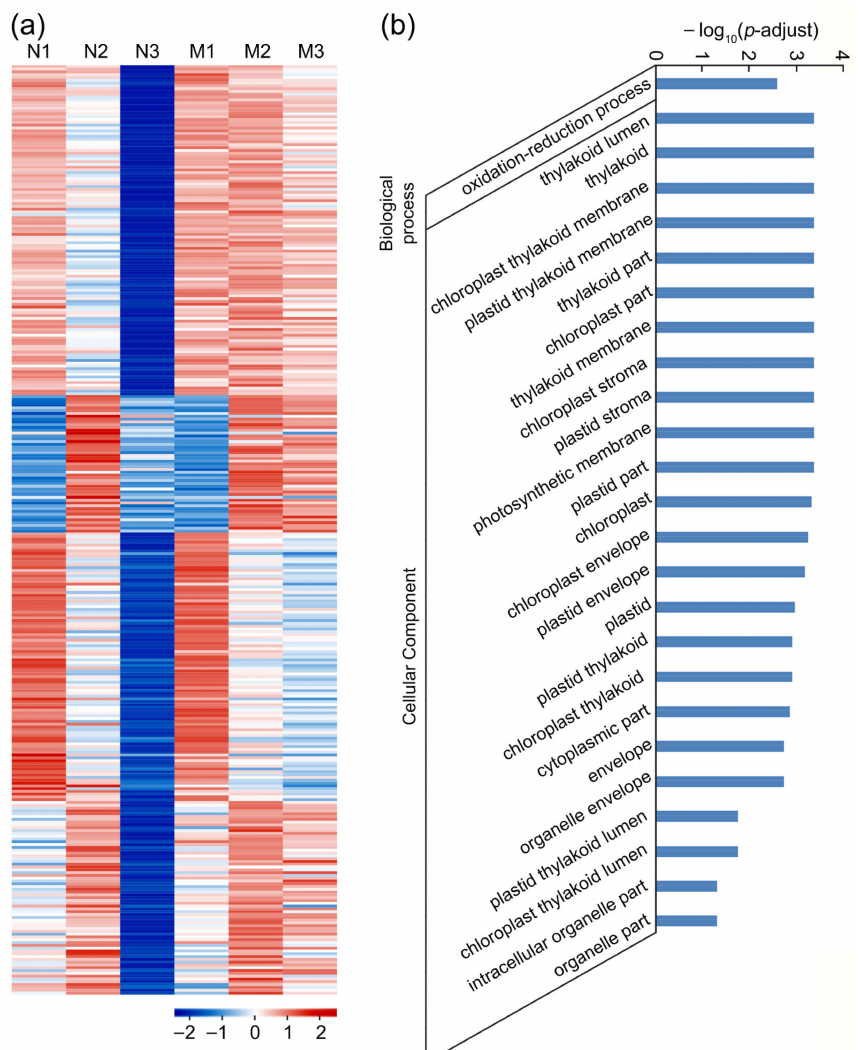
Figure 7. Expression patterns and GO enrichment analysis of the 332 genes involved in the recognition and fusion of the male–female gametes in rice. ( a ) Heat map of the 332 genes, showing significantly downregulated in N3 compared with N2, but not downregulated or slightly downregulated in M3 compared with M2. ( b ) GO enrichment analysis of the 332 genes. N1, WT pistil at 1–20 min after pollination; N2, WT pistil at 3.5 HAP; N3, WT pistil at 8 HAP; M1, the mutant pistil at 1–20 min after pollination; M2, the mutant pistil at 3.5 HAP; M3, the mutant pistil at 8